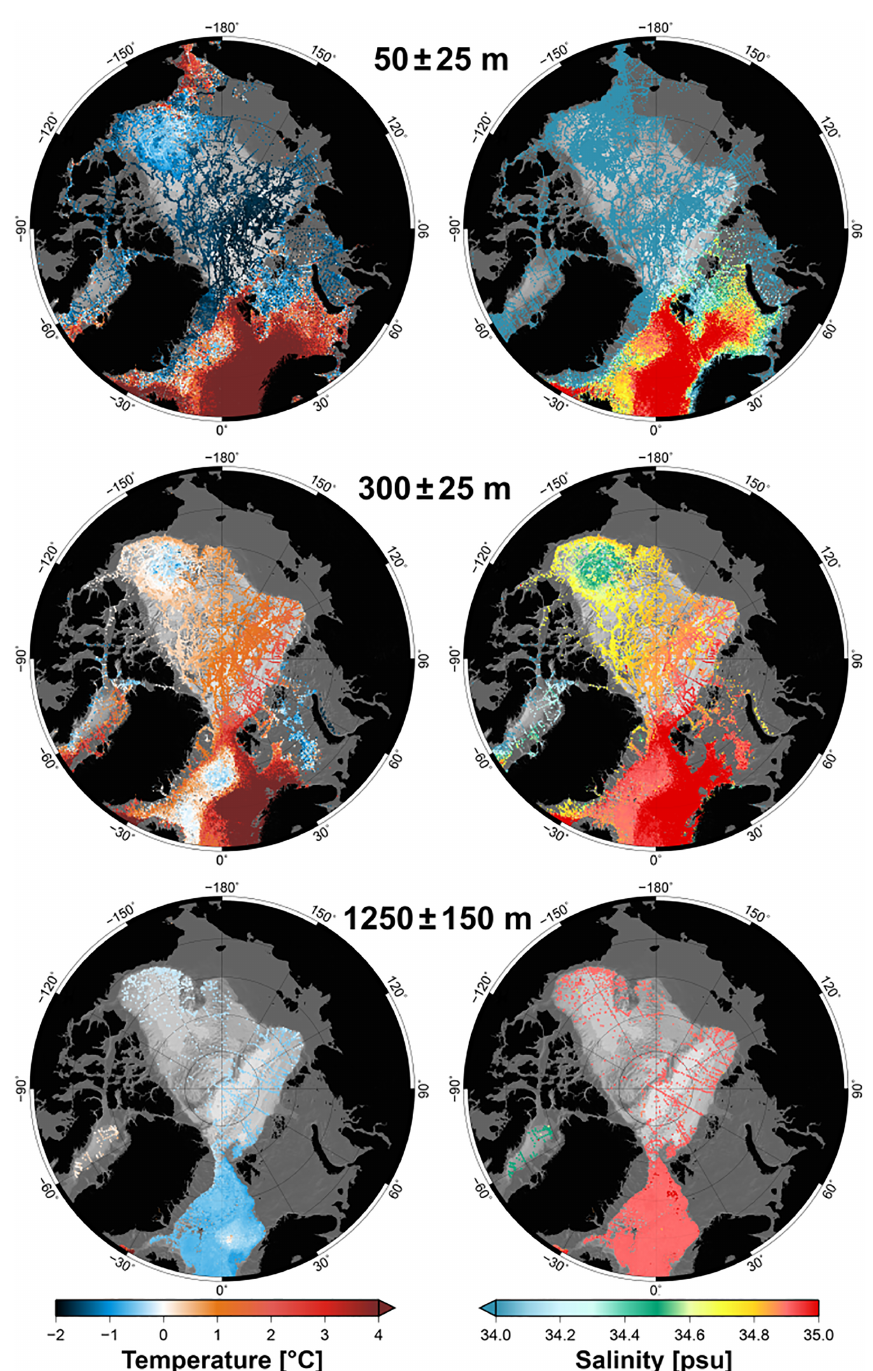
Figure 15. Temperature and salinity distribution in the Arctic Ocean for three selected depth ranges. The maps were obtained by averaging the data in the shown depth ranges for every available profile between 1980 and